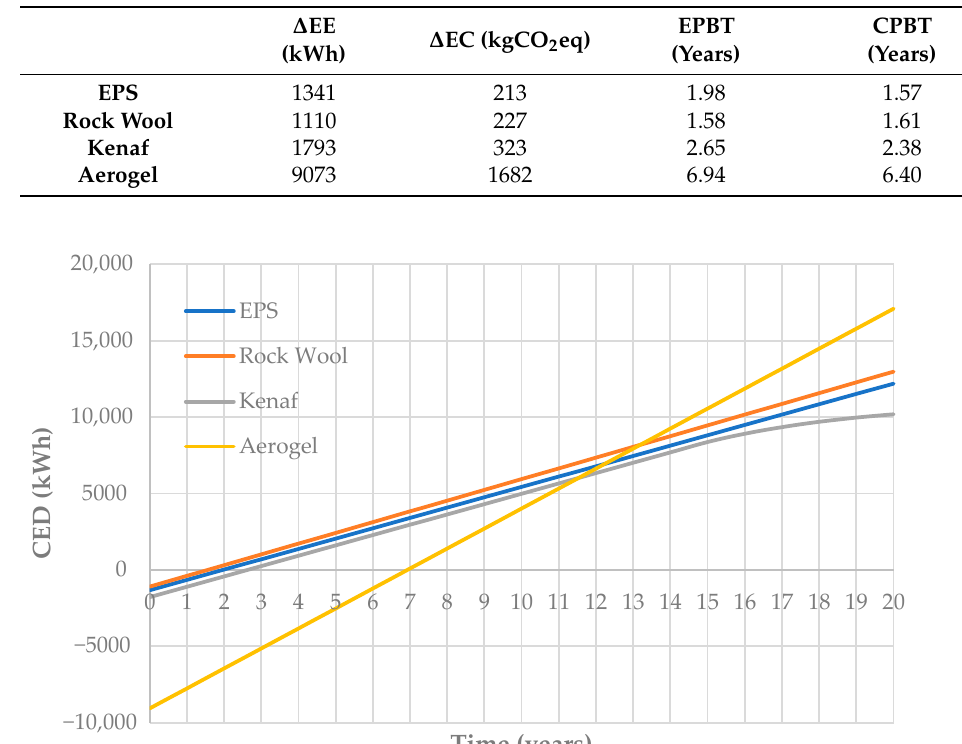
Table 8. Energy and carbon payback times of the various retrofit solutions.